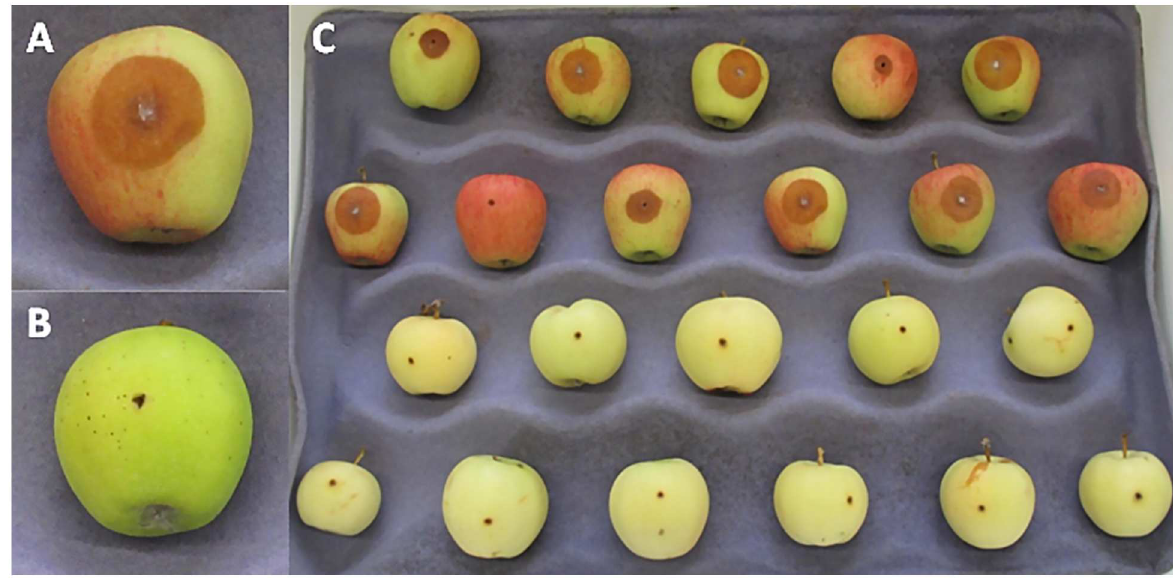
Fig 1. Blue mold ( Penicillium expansum ) lesions on wounded, mature apple fruit of susceptible and resistant individuals in the GMAL4593 population at 7 days post-inoculation (dpi). A: susceptibleresponseto infectionby P . expansum , B : highlyresistant responseto P . expansum , and C: in each test 11 replicate fruit of each progenywere inoculated and evaluatedat 7 dpi.